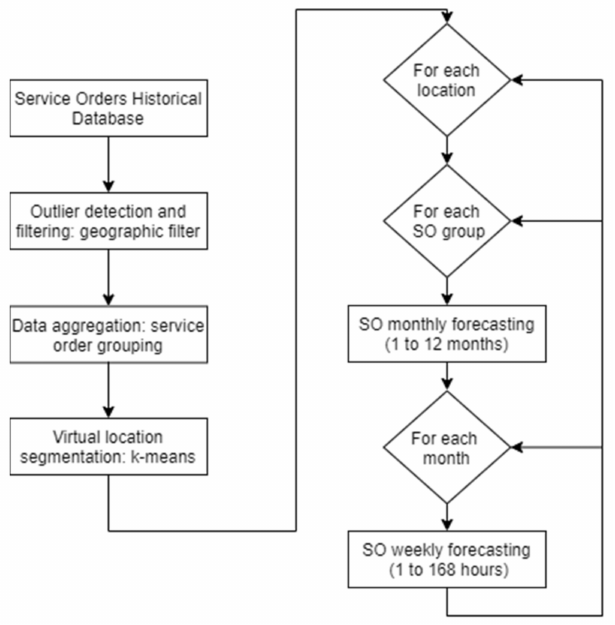
Figure 1. Flowchart summarizing the proposed spatio-temporal service order demand forecasting algorithm.